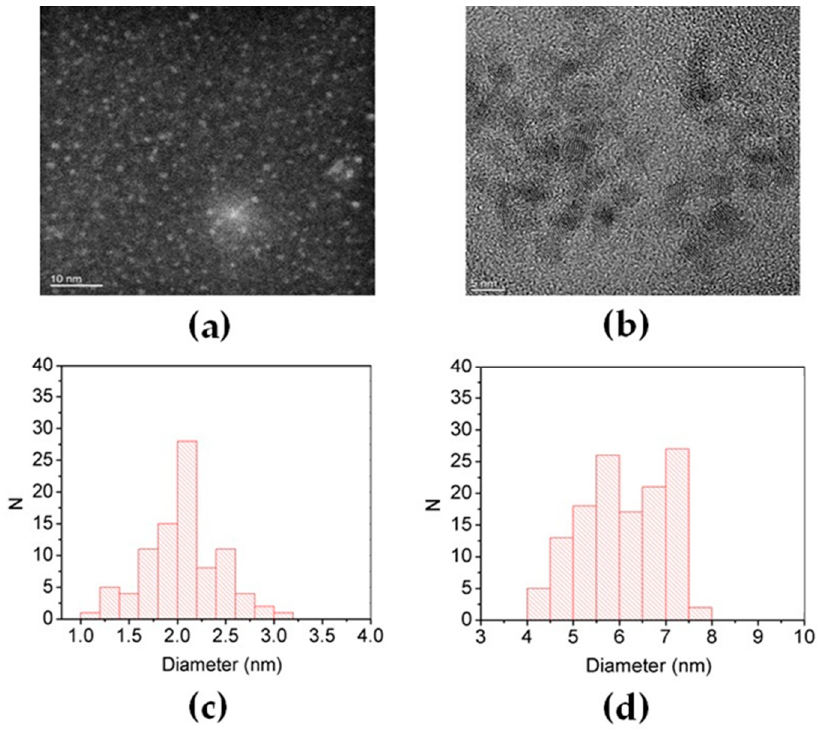
Figure 5. Images taken by ( a ) High Angle Annular Dark Field (HAADF)-STEM and ( b ) phase contrast HRTEM for green and red QDs produced in films annealed for 5 and 120 min at 150 °C, respectively. Distribution of the number of particles (N) as a function of the diameter of the particles for ( c ) green and ( d ) red QDs.